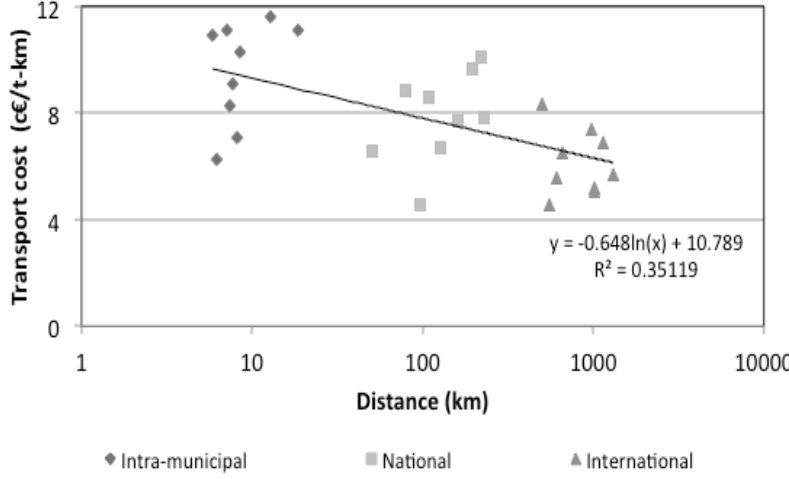
Figure 6. Operation cost and average transport distance on a logarithmic scale for Spain (2006).